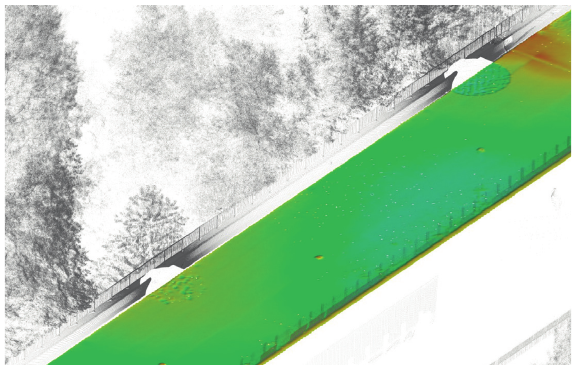
Figure 2: Typical results from geometry monitoring. Point-clouds obtained by terrestrial LiDAR enables automatic generation of a comparison between design requirements and construction results and its visualization.